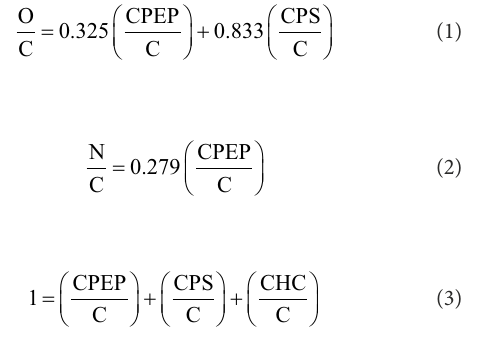
(Supplementary Table 2) such as Stenotrophomonas bentonitica (10.78 ± 0.31 × 10 − 4 mol/g; Ruiz-Fresneda et al., 2020), Sporomusa